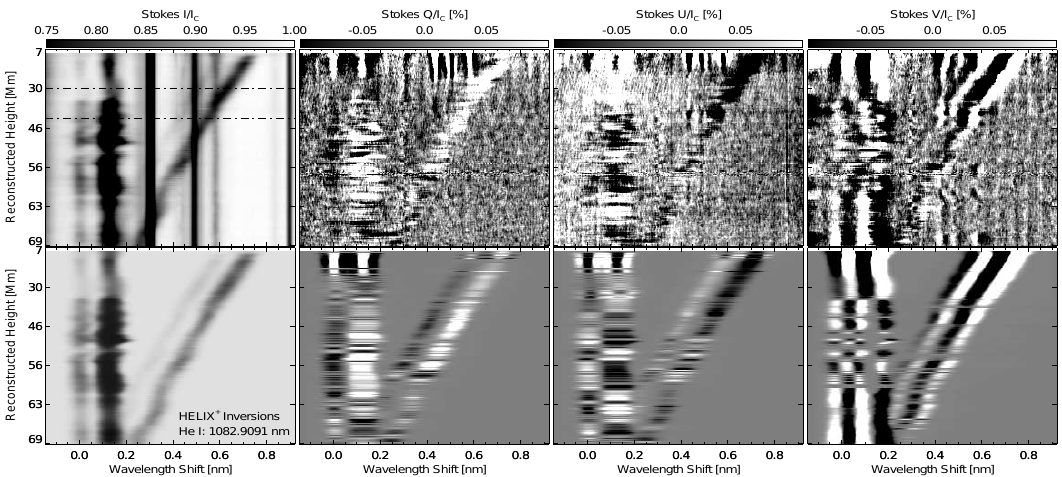
Figure 13: A composite spectrum of a strong He i 1083 nm downflow. At every pixel, the normal spectral line at the rest wavelength is seen along with a highly red-shifted second spectral line. The Stokes IQUV spectra are taken from along a curved path following a coronal condensation event. The upper panels show the measurements, while the lower panels show the resulting fitted spectra from the analysis, with the telluric and weak photospheric lines removed. The magnetic field measured in this event varies with height from approximately 100 G at 50 Mm to over 1000 G at 10 Mm and below. Image reproduced with permission from Schad (2013), copyright by the